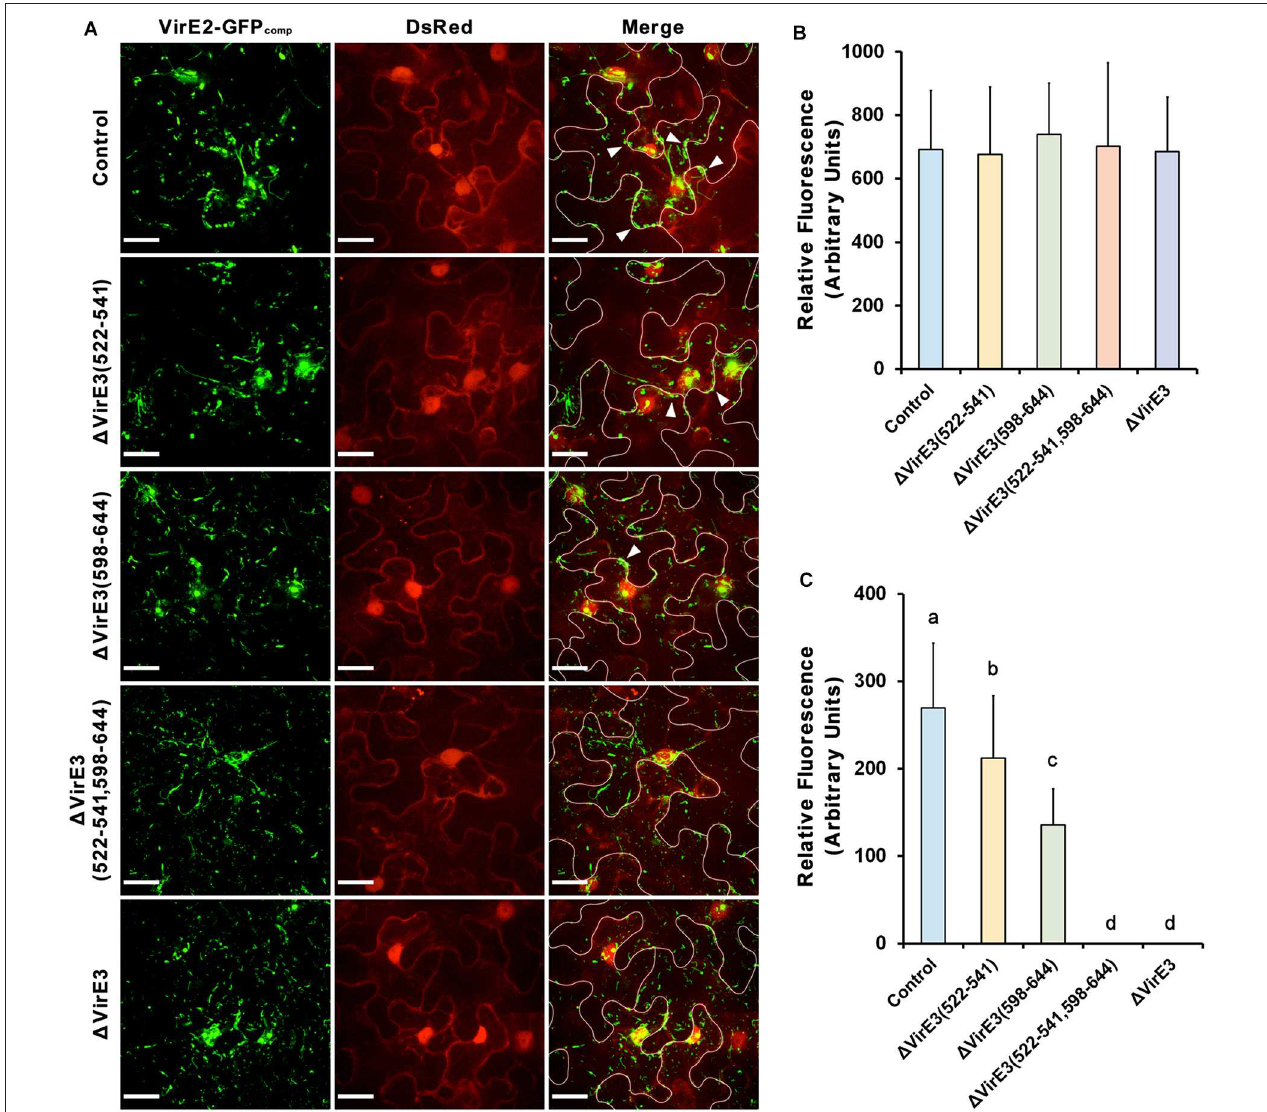
FIGURE 4 | Deletions of VirE2-interacting domains of VirE3 affect VirE2 accumulation at the host cell border. (A) N. benthamiana (Nb308A) leaves were infiltrated with A. tumefaciens EHA105 virE2::GFP11 (control), EHA105 virE2::GFP11 1 VirE3(522-541), EHA105 virE2::GFP11 1 VirE3(598-644), EHA105 virE2::GFP11 1 VirE3(522-541,598-644) or EHA105 virE2::GFP11 1 VirE3. White lines are added to indicate borders between leaf epidermal cells. Arrowheads point to VirE2 aggregates at the plant cell border. Scale bars, 20 µ m. (B) The total fluorescence intensity of VirE2-GFP comp signals was measured in each image. Data are presented as means ± SDs of n = 20 independent samples. (C) The fluorescence intensity of VirE2-GFP comp signals associated with host cell borders was measured in each image. Data are presented as means ± SDs of n = 20 independent samples. p < 0.01. worked as expected and no cross-complementation